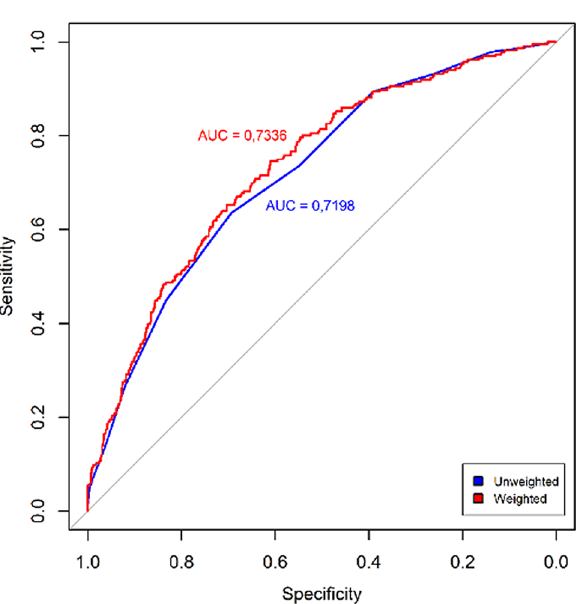
Figure 2. Receiver operating characteristics (ROC) curves of the two genetic risk scores, unweighted (uGRS) and weighted (wGRS). Areas under curves (AUC) are indicated. The straight line represents the ROC expected by chance